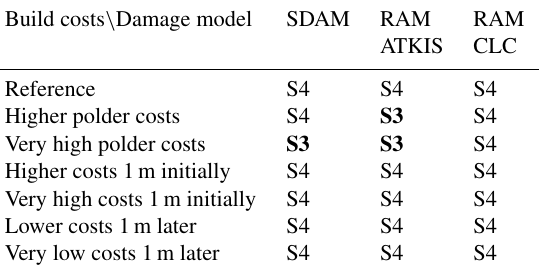
¹ Figure 10. Modeled inundation depths for a flood event of 700m 3 s − 1 and four different protection systems (Data source: Geobasisdaten © Bayerische Vermessungsverwaltung, www.geodaten.bayern.de, last access: 5 May 2018). Table 8. Initial protection system recommended by optimization framework. In the case of higher polder costs and SDAM, the rec- ommendation differs between projection sets. SDAM